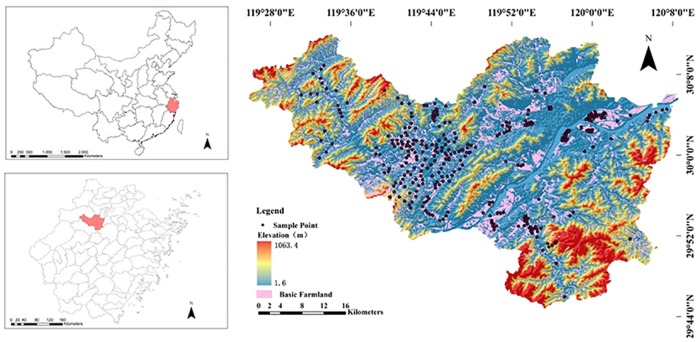
Location of the study area.